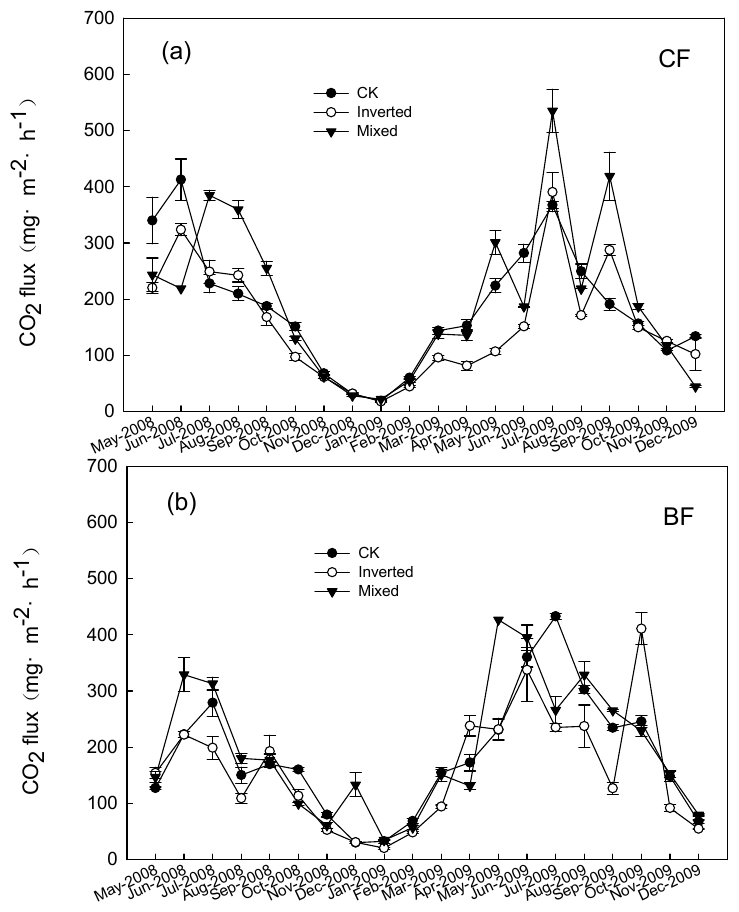
Figure 2. Fluxes of CO 2 in a coniferous forest (CF) ( a ) and a broad-leaved forest (BF) ( b ) in different soil column treatments: CK, inverted and mixed. Error bars represent standard errors of the mean ( n = 6).